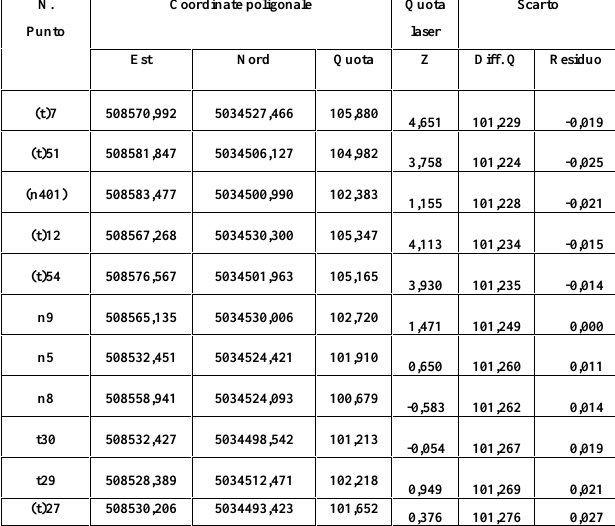
Table 2. Height trasformation between the two coordinates systems: